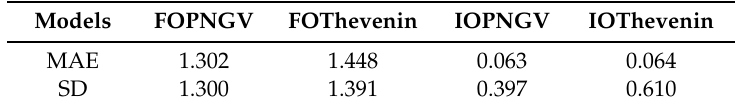
Table 1. Terminal output errors under static conditions (Unit: mV).